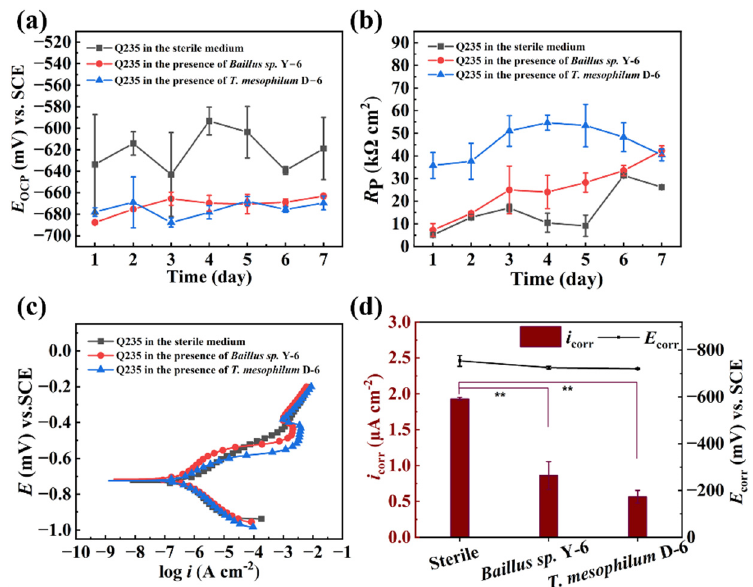
Figure 2. Electrochemical measurements of Q235 coupons in different culture media: ( a ) E OCP , ( b ) R p , ( c ) potentiodynamic polarization curves after 7 days incubation and ( d ) corresponding corrosion current density and corrosion potential. The black, red and blue curves represent results of sterile media, T. mesophilum D-6 and Bacillus sp. Y-6 cultures.